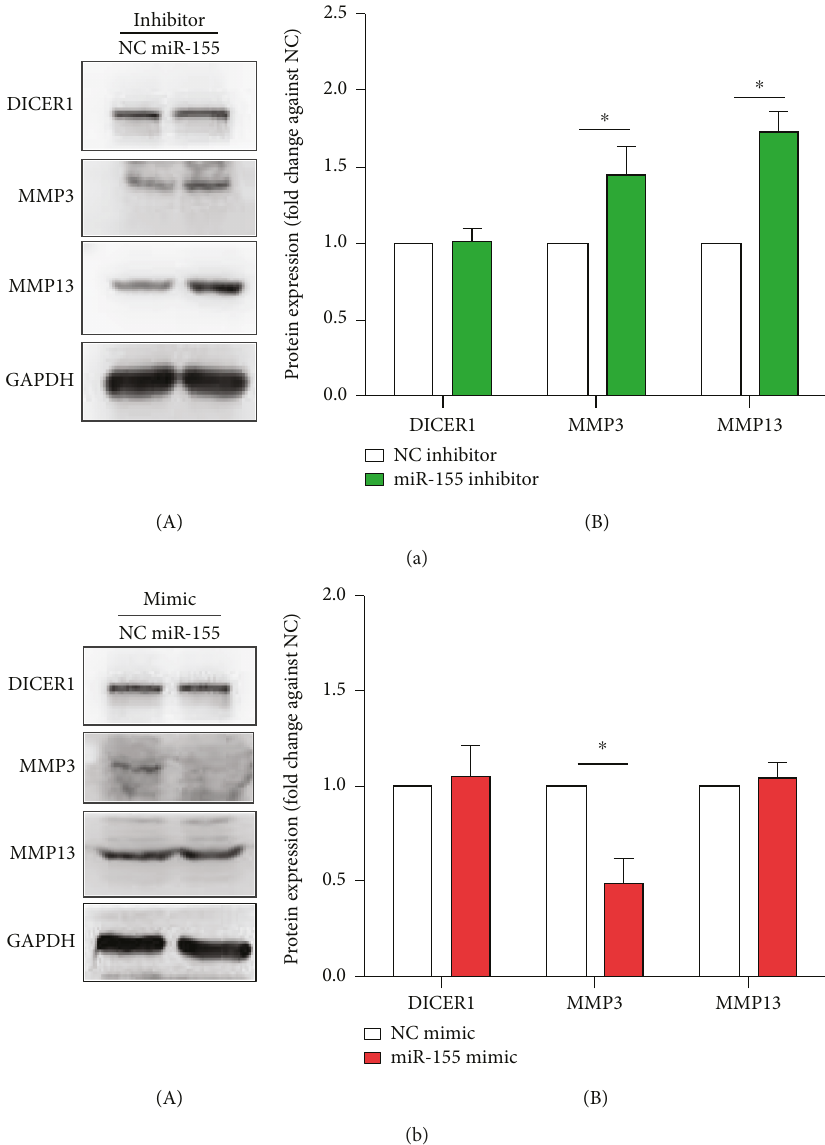
Figure 5: Altered expression of MMP3 and MMP13 caused by gain or loss of miR-155 function for 48 h in human synoviocytes SW982. (a) Western blotting result of DICER1, MMP3, and MMP13 in 10 nM miR-155 inhibitor-treated cells. (A) Representative images; (B) quantitative results. (b) Western blotting result of DICER1, MMP3, and MMP13 in 10 nM miR-155 mimic-treated cells. (A) Representative images; (B) quantitative results. Bar: mean ± SEM from three independent cell experiments, and triplicates were used for each cell transfection experiment. ∗ P < 0 05 using the Mann-Whitney